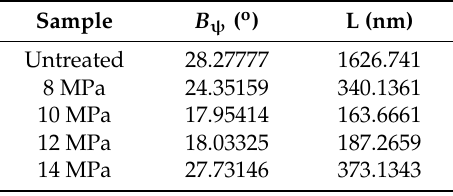
Figure 6. Small angle X-ray scattering (SAXS) patterns of PAN fibers treated at different pressures. Table 1. The characterization of microvoid structures in PAN fibers at different pressures during the hot-drawing process.